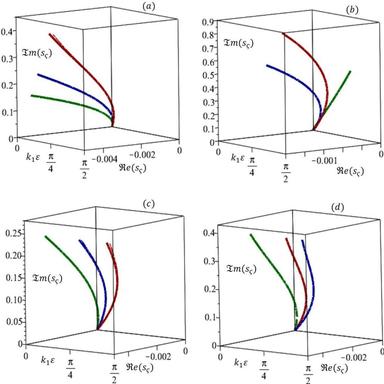
Dispersion functions associated to compressional waves travelling along e1. Comparison between the homogenized model 1 (continuous line) and homogenized model 2 (dotted line); (a) is obtained by setting τ 1 ς = τ 2 ς = 2, η = 1, rρ = rE = 10, ν˜1 = ν˜2 = 0.2 and by varying the dimensionless elastic parameter γ = 1/20 (red curves), γ = 1/10 (blue curves) and γ = 1/5 (green curves); (b) is obtained by setting η = 1, rρ = rE = 10, ν˜1 = ν˜2 = 0.2, γ = 1/10 and by varying the dimensionless relaxation time τ 1